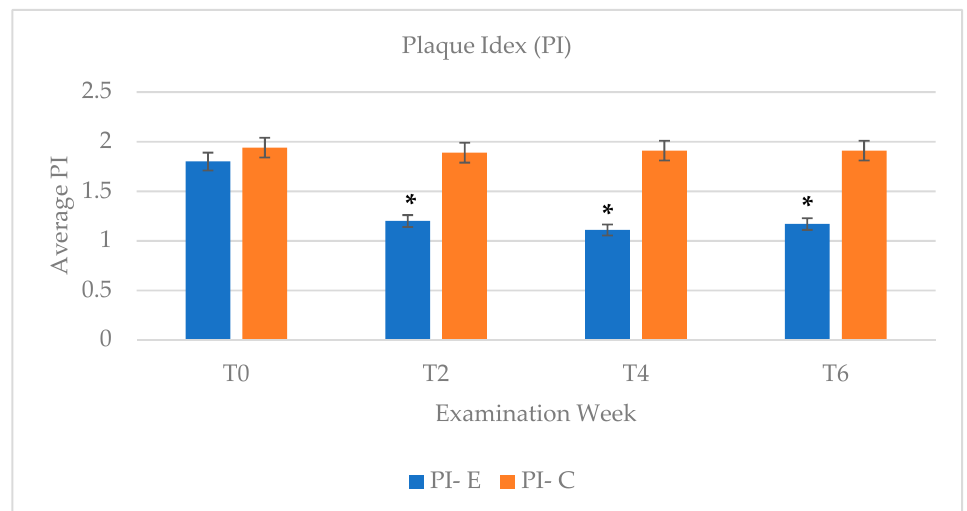
Figure 5. PI measurements were compared between experimental group (E) and control group (C) and categorized by examination week. Each bar represents an average PI score of each group at each evaluation week. The PI measurements received a κ of 0.837 and an inter-examiner agreement of 82%. (T0—baseline/week 0; T1—week 1; T2—week 2; T4—week 4; T6—week 6) (* p < 0.05).